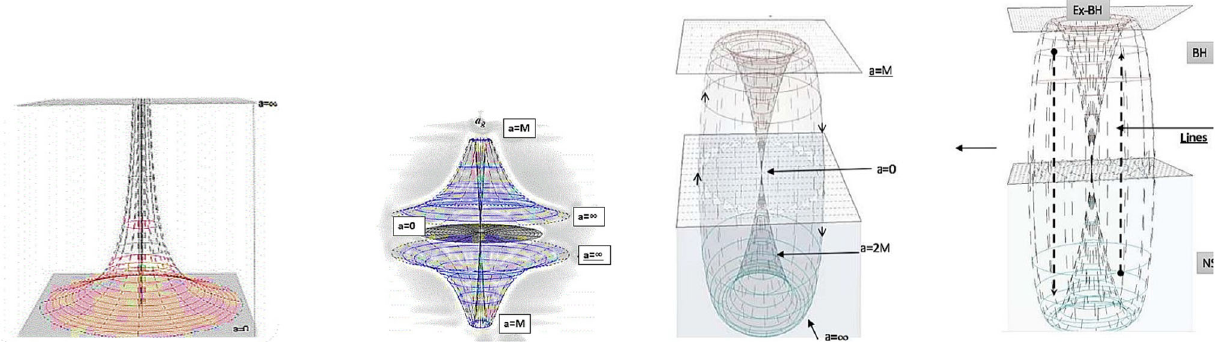
Fig. 12 Schematic representation of the BHs – NSs correspondence. See also the a g ( a 0 ) function of Fig. 13. Right first panel: The spin a = 2 M /ω between the planes a = 0 and a = ∞ – cf. Eq. (12). Third and fourth panels: Representation of the BHs – NSs correspondence. An